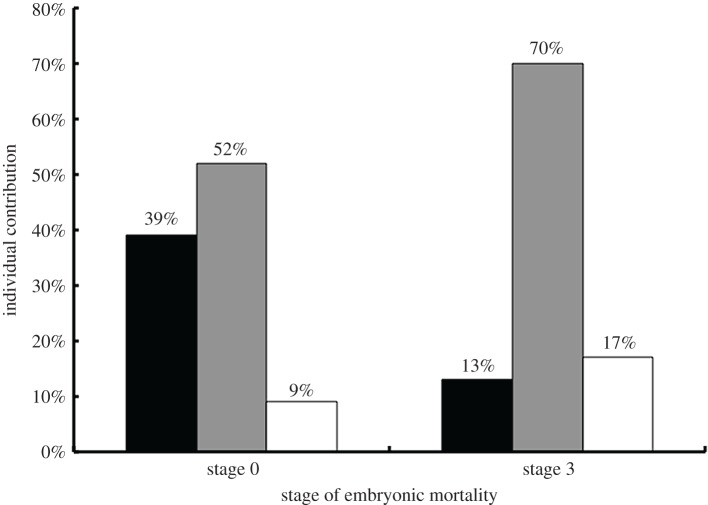
Results of hierarchical partitioning analysis investigating whether precipitation and temperature influence the stage when embryos die during development. Black columns represent precipitation before laying (one month), grey columns represent precipitation during developmental stage and white columns represent temperature during developmental stage. Values shown are unitless effect sizes and there is no standard accepted method for generating standard errors for these values. Thus no error bars are shown.